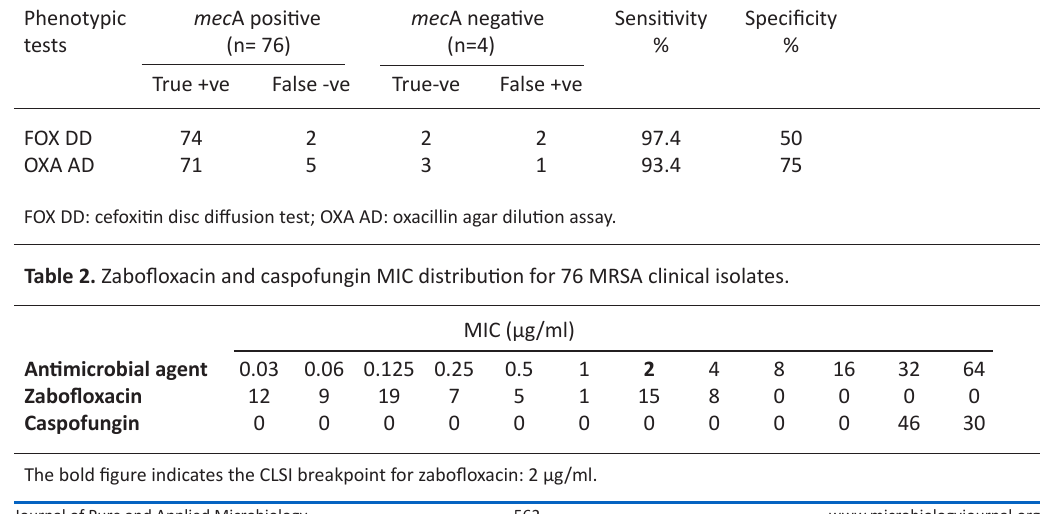
The bold figure indicates the CLSI breakpoint for zabofloxacin: 2